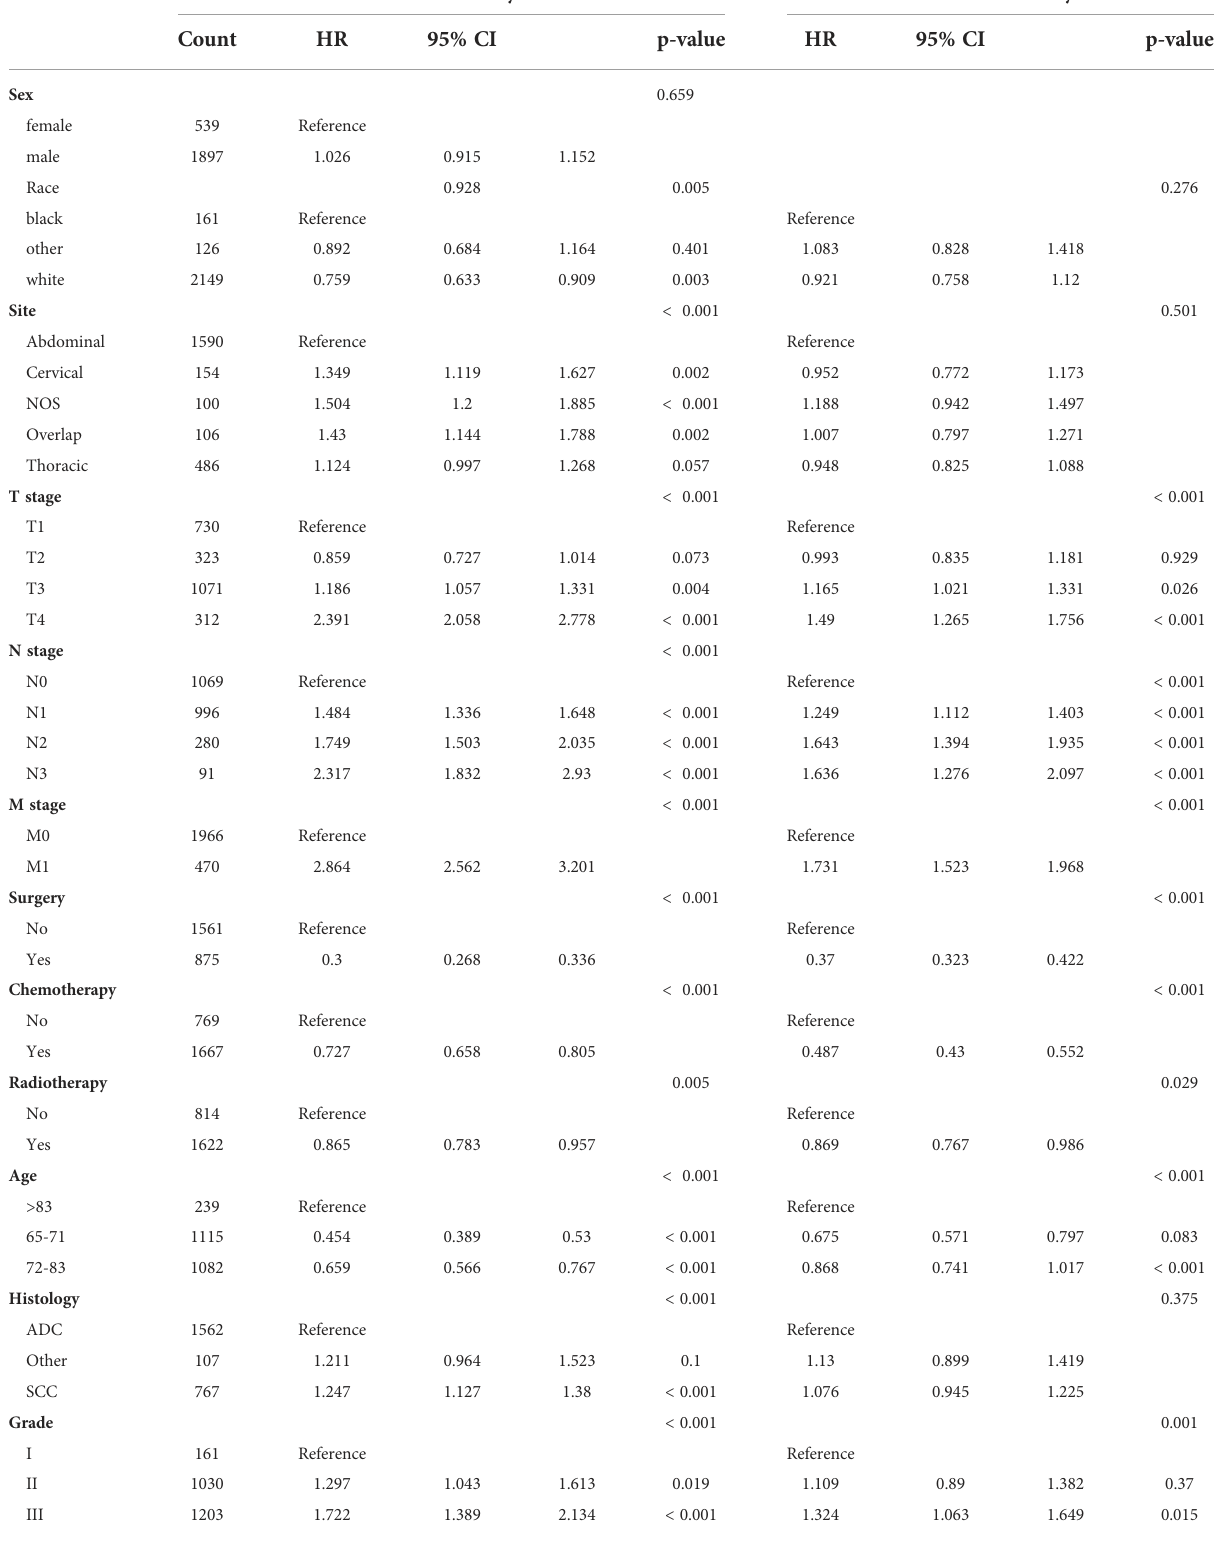
TABLE 2 Univariate and multivariate Cox analysis of prognostic